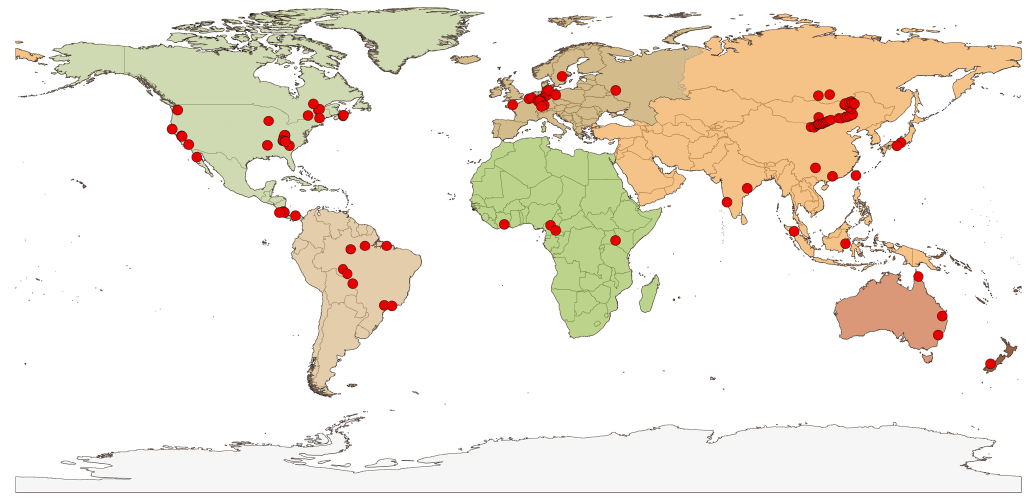
Figure 1. Locations of the 176 soil profiles used to calculate β values in this study.